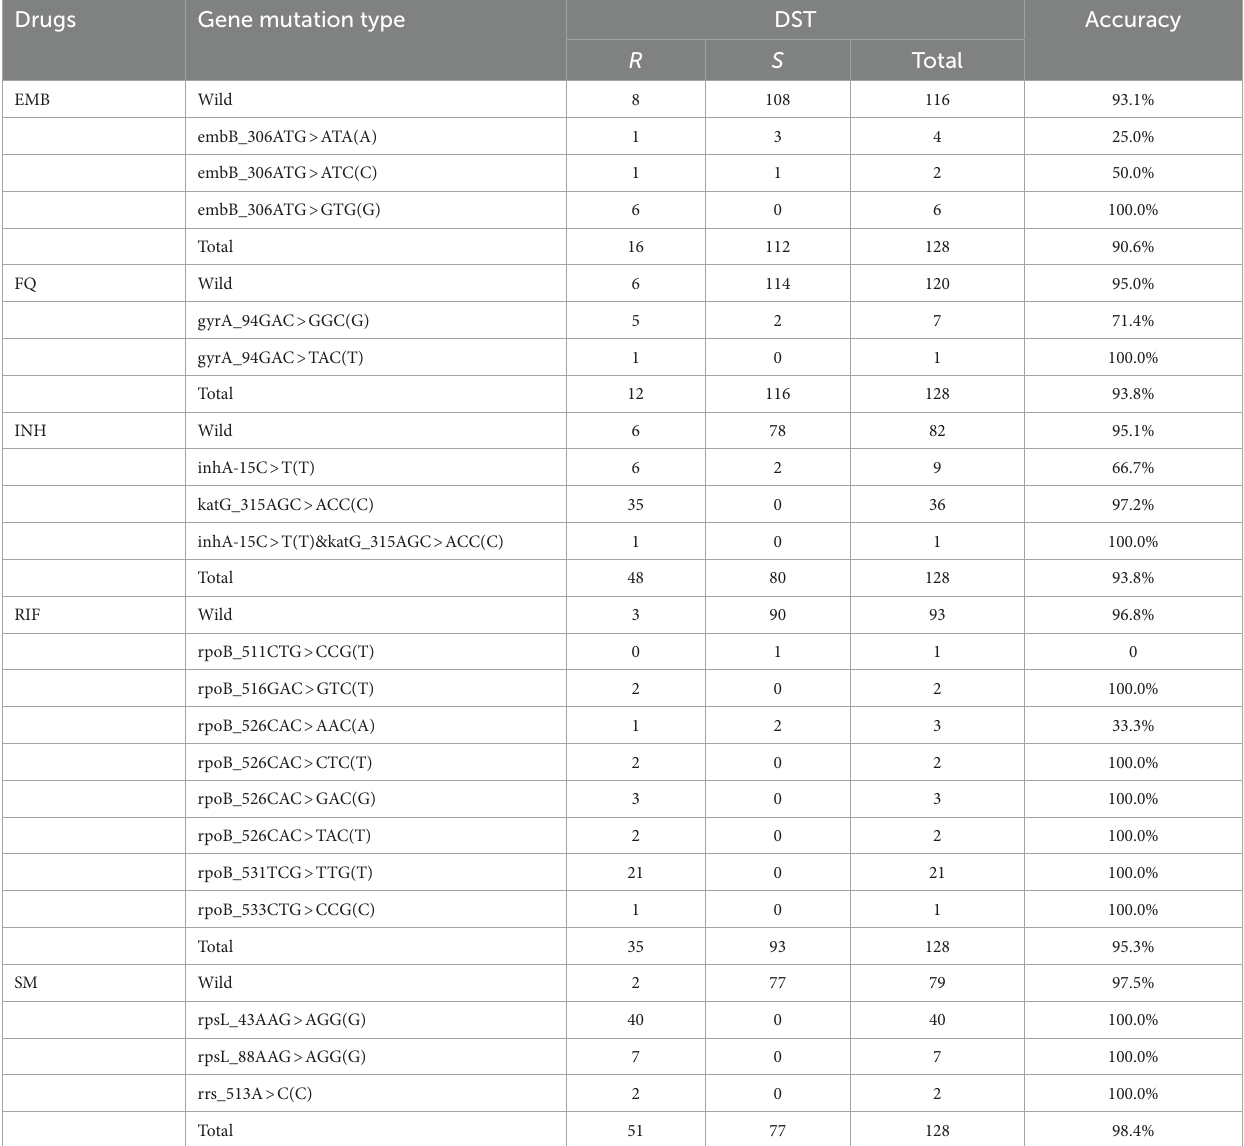
TABLE 5 Relationship between MassARRAY genotype and DST phenotype. Drugs Gene mutation